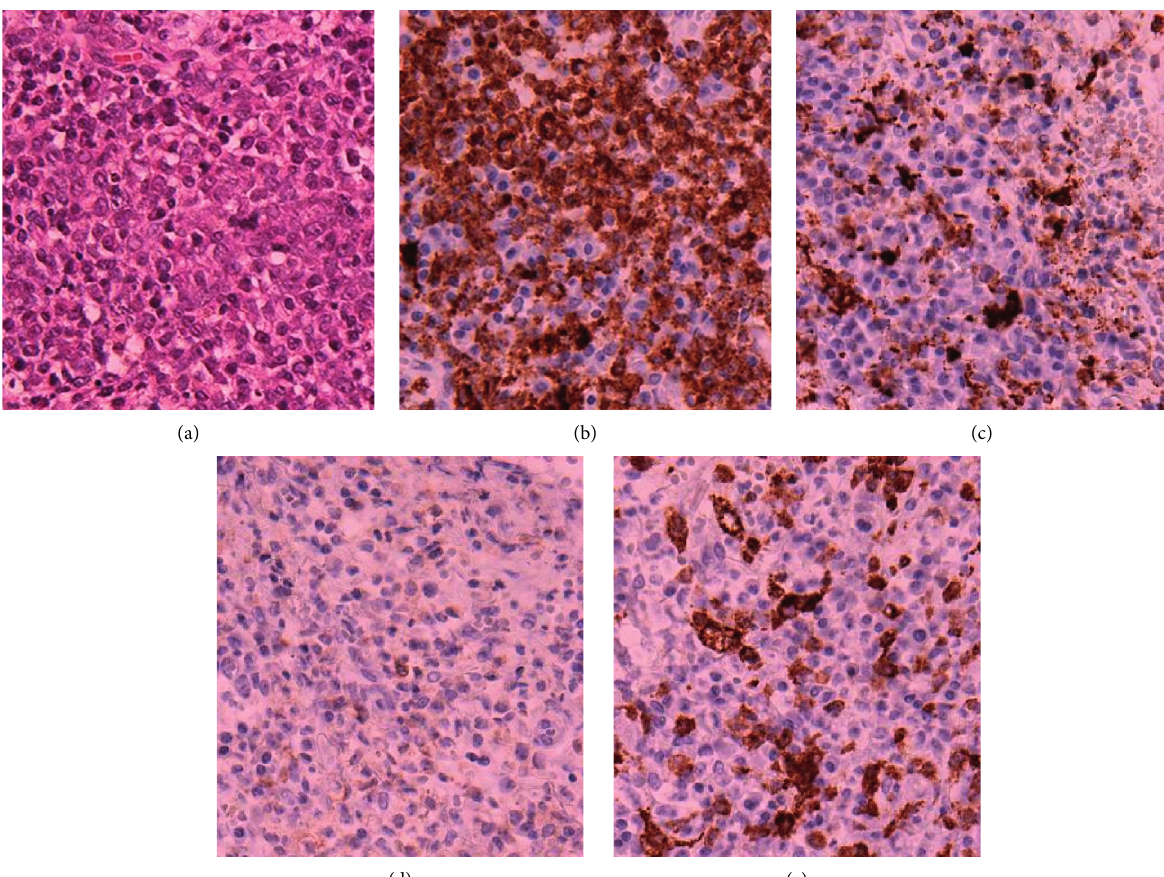
Figure 3: The histological findings of the tumor located in the left groin. A biopsy specimen showed the proliferation of tumor cells with a high nuclear/cytoplasmic ratio on hematoxylin and eosin staining ( × 20) (a). Immunohistochemical staining ( × 20) of tumor cells was positive for myeloperoxidase (b), partially positive for cluster of differentiation (CD) 68 (c), negative for CD4 (d), and negative for CD123 (e).